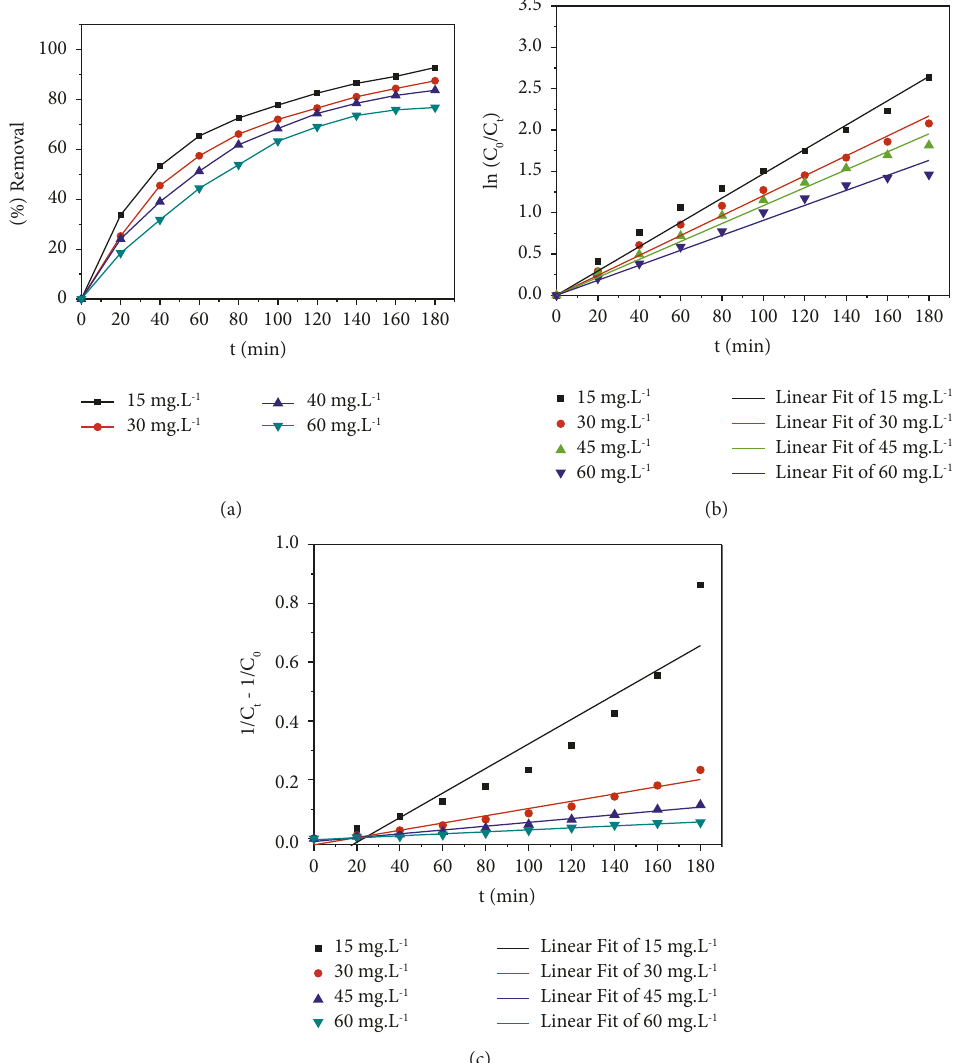
Figure 5: (a) Effect of initial concentration of MO on the degradation of methyl orange. (b) First- and (c) second-order kinetic model of the removal of MO. Experimental conditions: mass of WO3 � 0.25g and pH � 4. Table 2: Rate parameters of the removal of MO by WO Initial concentration (mg · L − 1